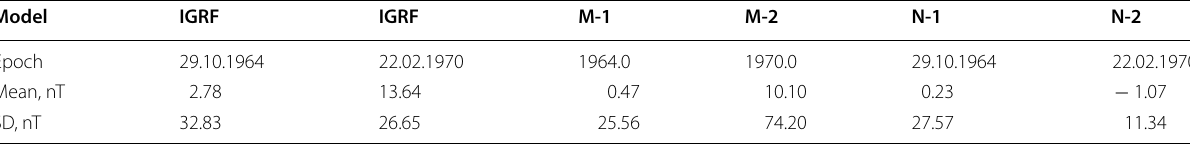
M-1 and M-2 are IZMIRAN models based on Kosmos-49 and Kosmos-321 data, respectively (Dolginov et al. 1967, 1976) (discussed in Sections “Verification of historic models of the geomagnetic field”, “Comparison of the model predictions with observatory data”); N-1 and N-2 are the models proposed in this research (discussed in Sections “A new geomagnetic field model based on satellite data”, “Comparison of the model predictions with observatory data”).